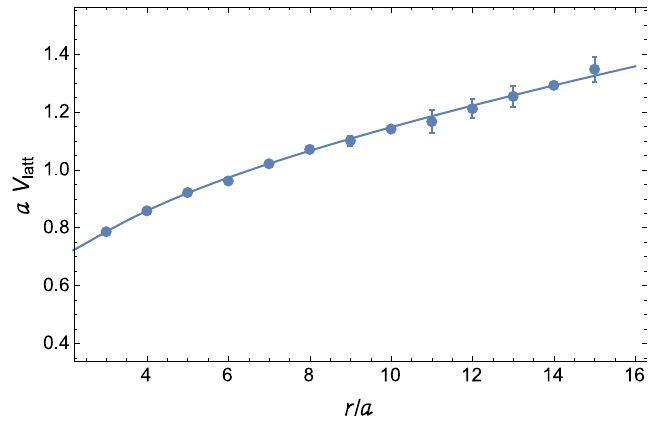
Figure 3 . Interpolation of a jackknife lattice data for d = 1 and i = 1. The reduced (cid:31) 2 [de(cid:12)ned in eq. (D.1)] is given by (cid:31) 2 j d =1 ;i =1 = d : o : f : = 6 : 9 = (13 (cid:0) Inter